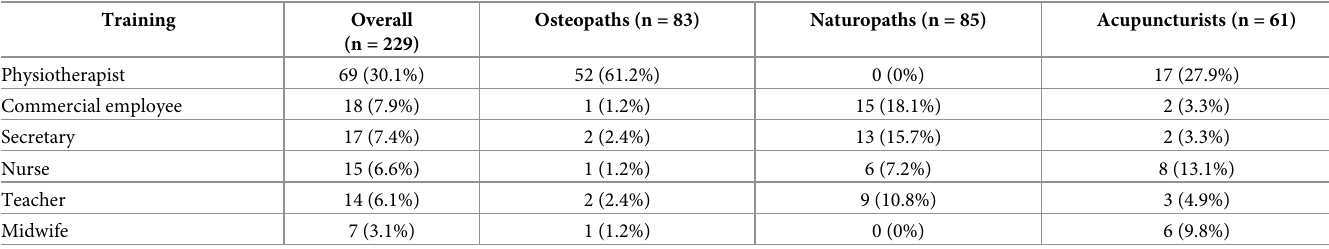
Table 3. Participants’ training outside the CM